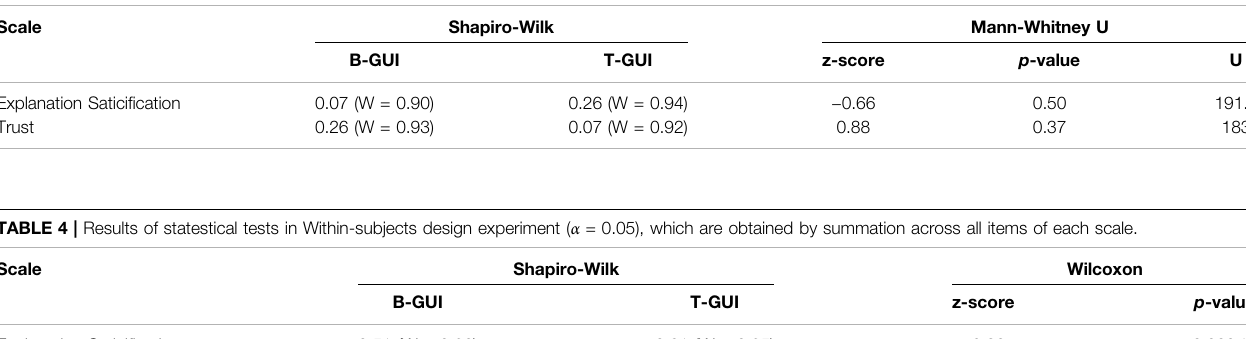
TABLE 3 | Results of statestical tests in Between-subjects design experiment ( α = 0.05), which are obtained by summation across all items of each scale.